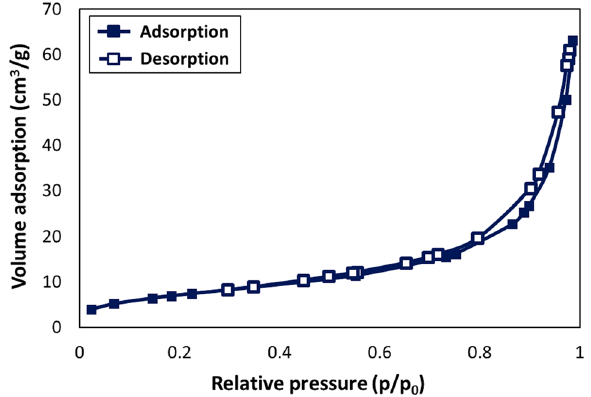
Figure 7. The N 2 adsorption–desorption isotherms of Fe 3 O 4 @Cur/Mel-Ag magnetic nanocomposite.